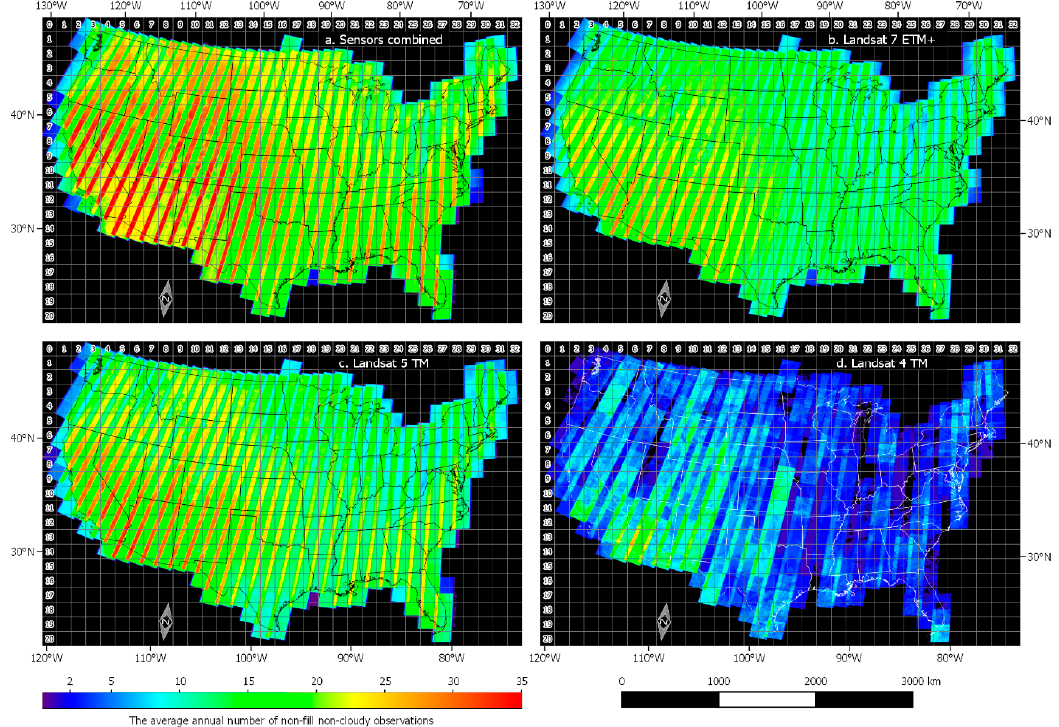
Figure 6. The average annual number ( µ sensor Equation (1)) of non-fill non-cloudy observations at each CONUS ARD 30 m pixel location over the 36 year study period for ( a ) Landsat 4 TM, 5 TM and 7 ETM+ combined, ( b ) Landsat 7 ETM+, ( c ) Landsat 5 TM, ( d ) Landsat 4 TM.